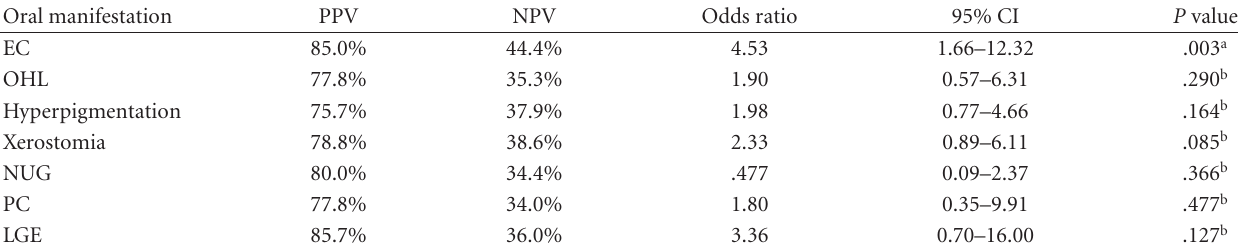
Table 5: Predictive values of oral manifestations for CD4/CD8 ratio <